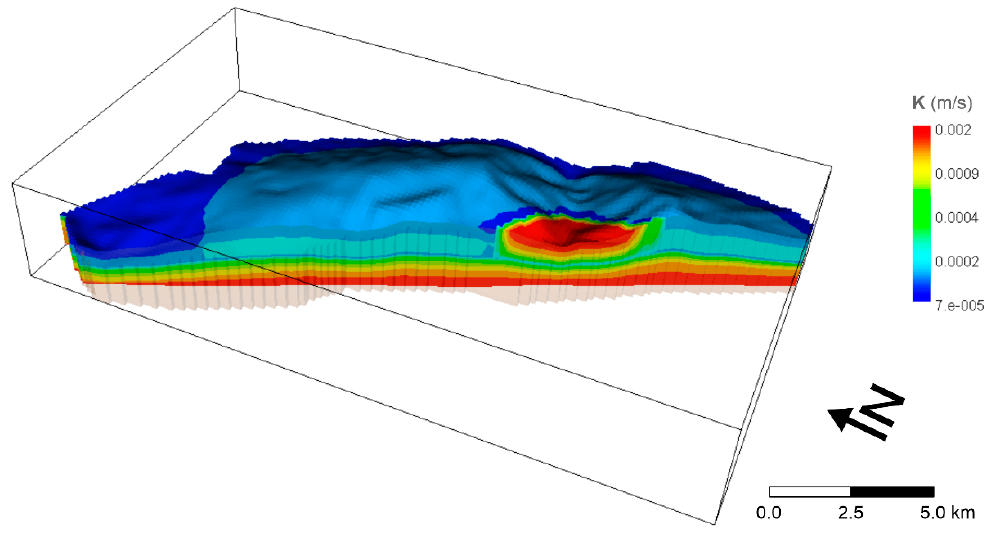
Figure 3. Three-dimensional cropped map (along the transect of Figure 1) of the hydrogeological units represented in the domain of the numerical model, vertical exaggeration 1:1.